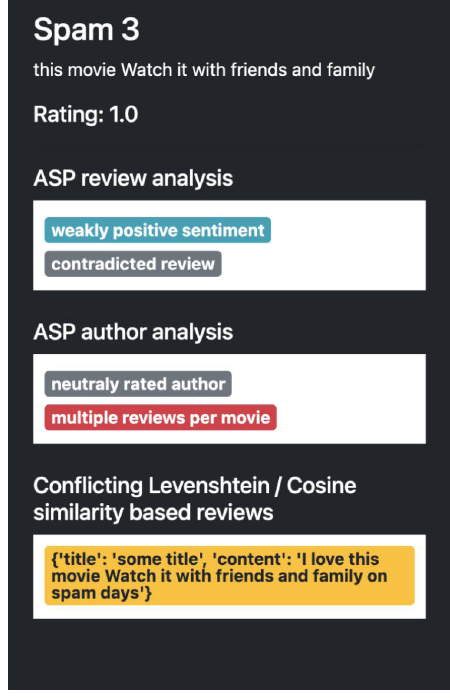
Figure 6. Contradicted review